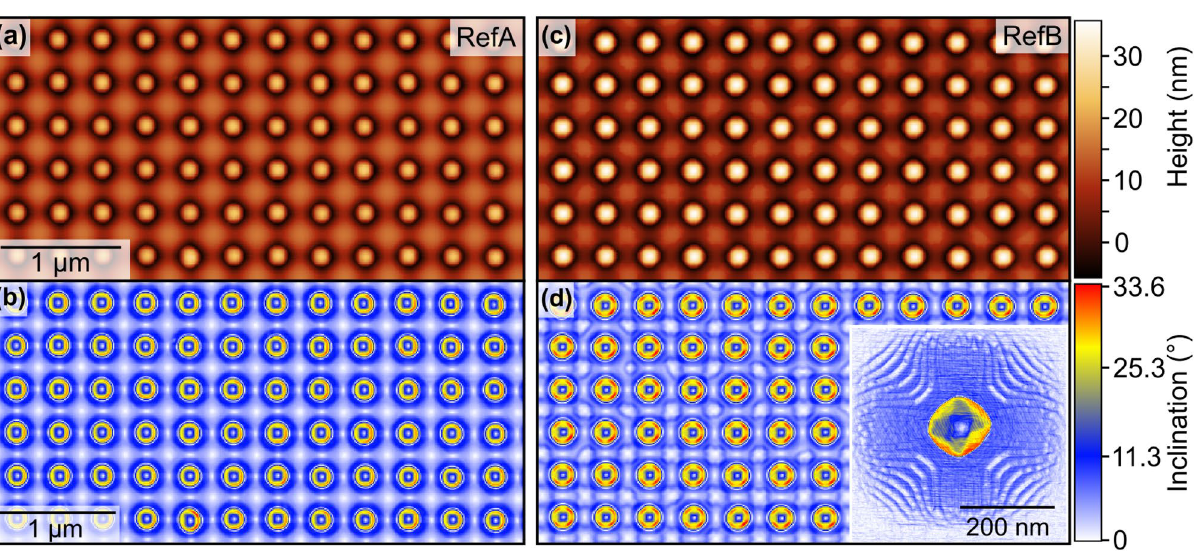
clearly distinguished Si spacer and to the upper QD. Moreover, the upper QD has a significantly larger volume